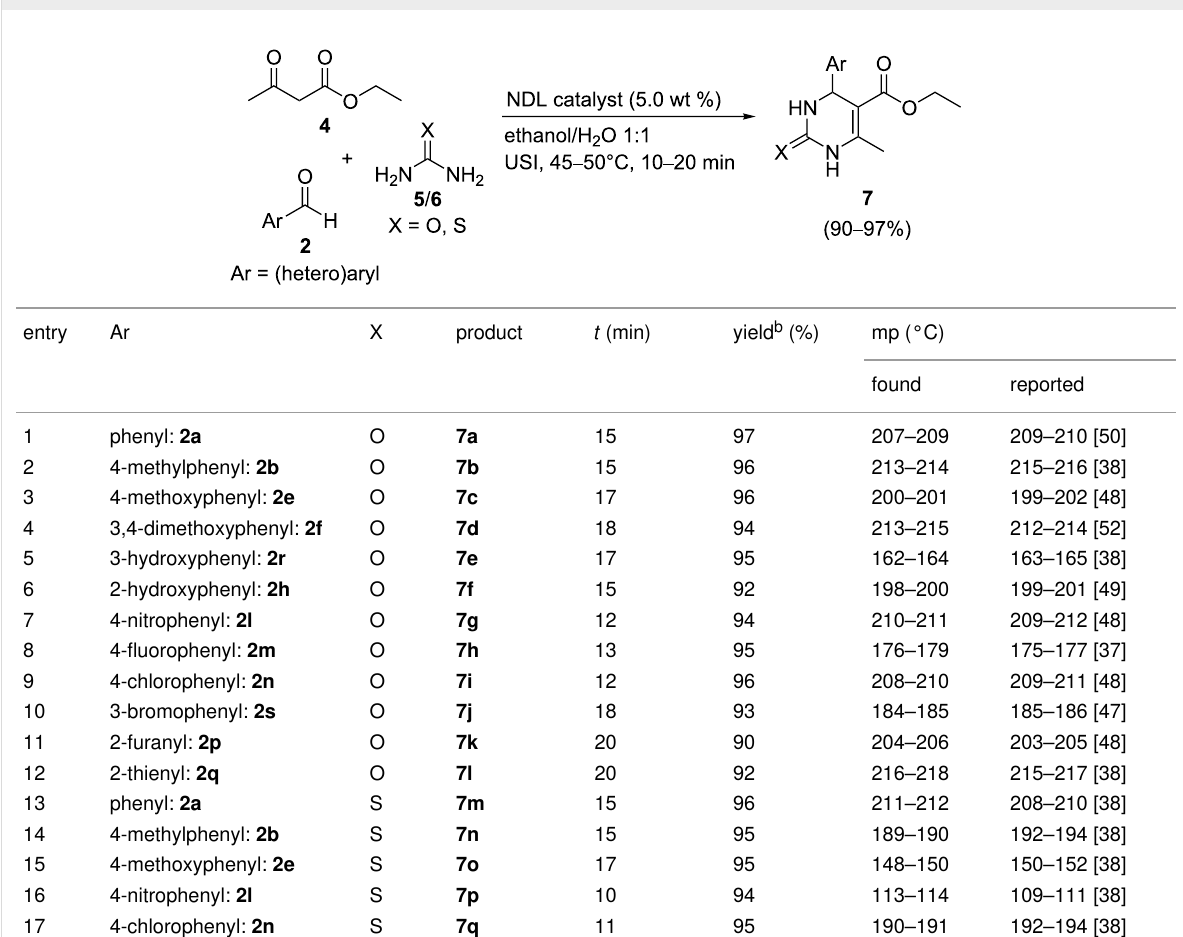
Table 6: NDL-catalyzed synthesis of dihydropyrimidinone/-thione derivatives 7 .